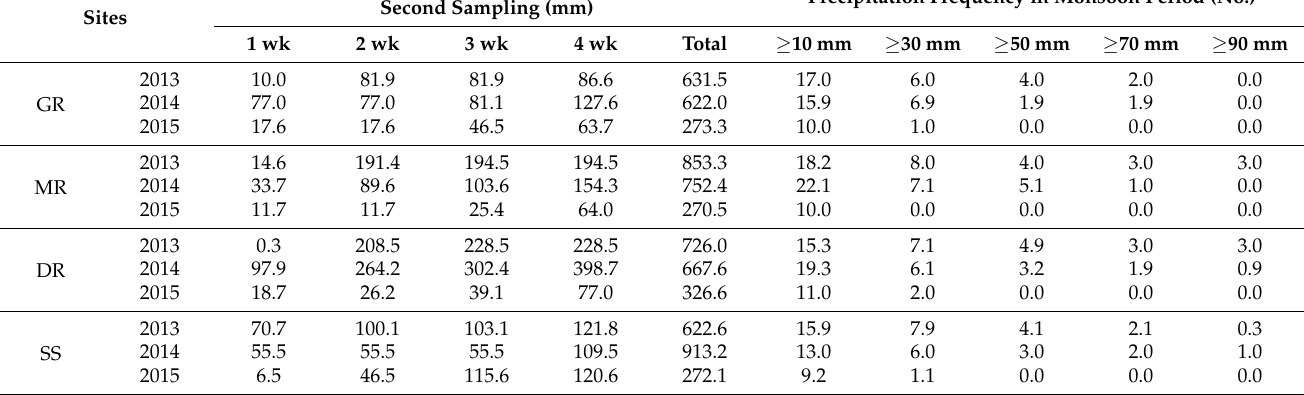
Table 2. Characteristics of soil in four central western major streams of the Korean